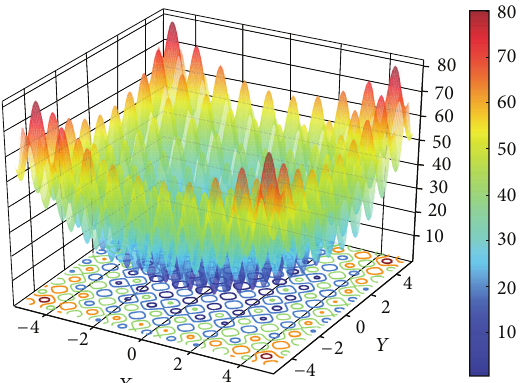
Figure 2: This illustration of Rastrigin’s function shows its highly multimodal nature, and it is difficult to visually identify the global optima at [0, 0] .